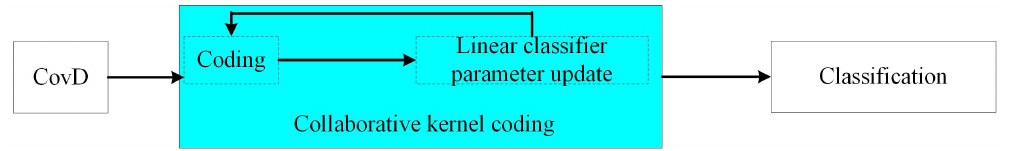
Figure 2. Illustration of the supervised collaborative kernel coding model.